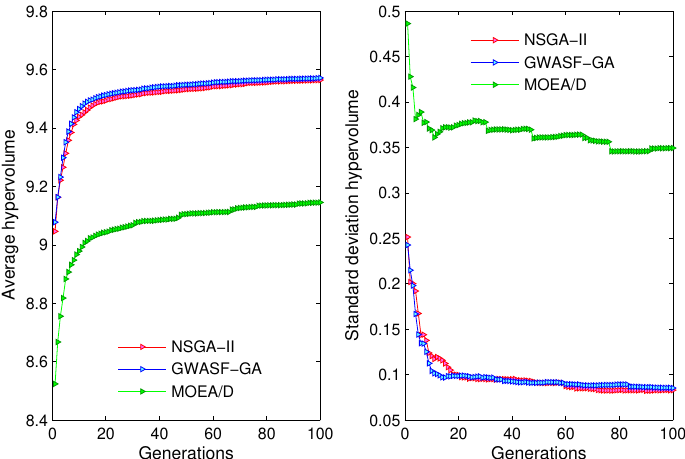
Figure 7. Evolution of the average hypervolume ( left ); and evolution of the standard deviation hypervolume ( right ) for NSGA-II, GWASF-GA and MOEA/D ( N =